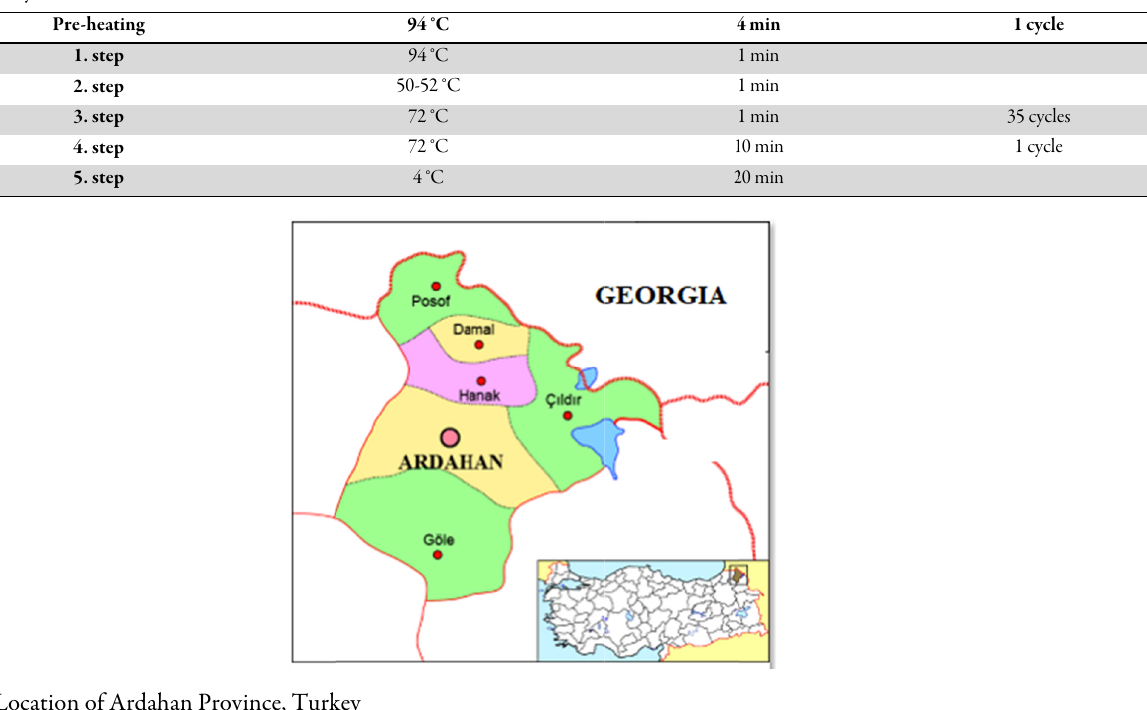
Table 2. Cycles and conditions of ISSR-PCR reactions